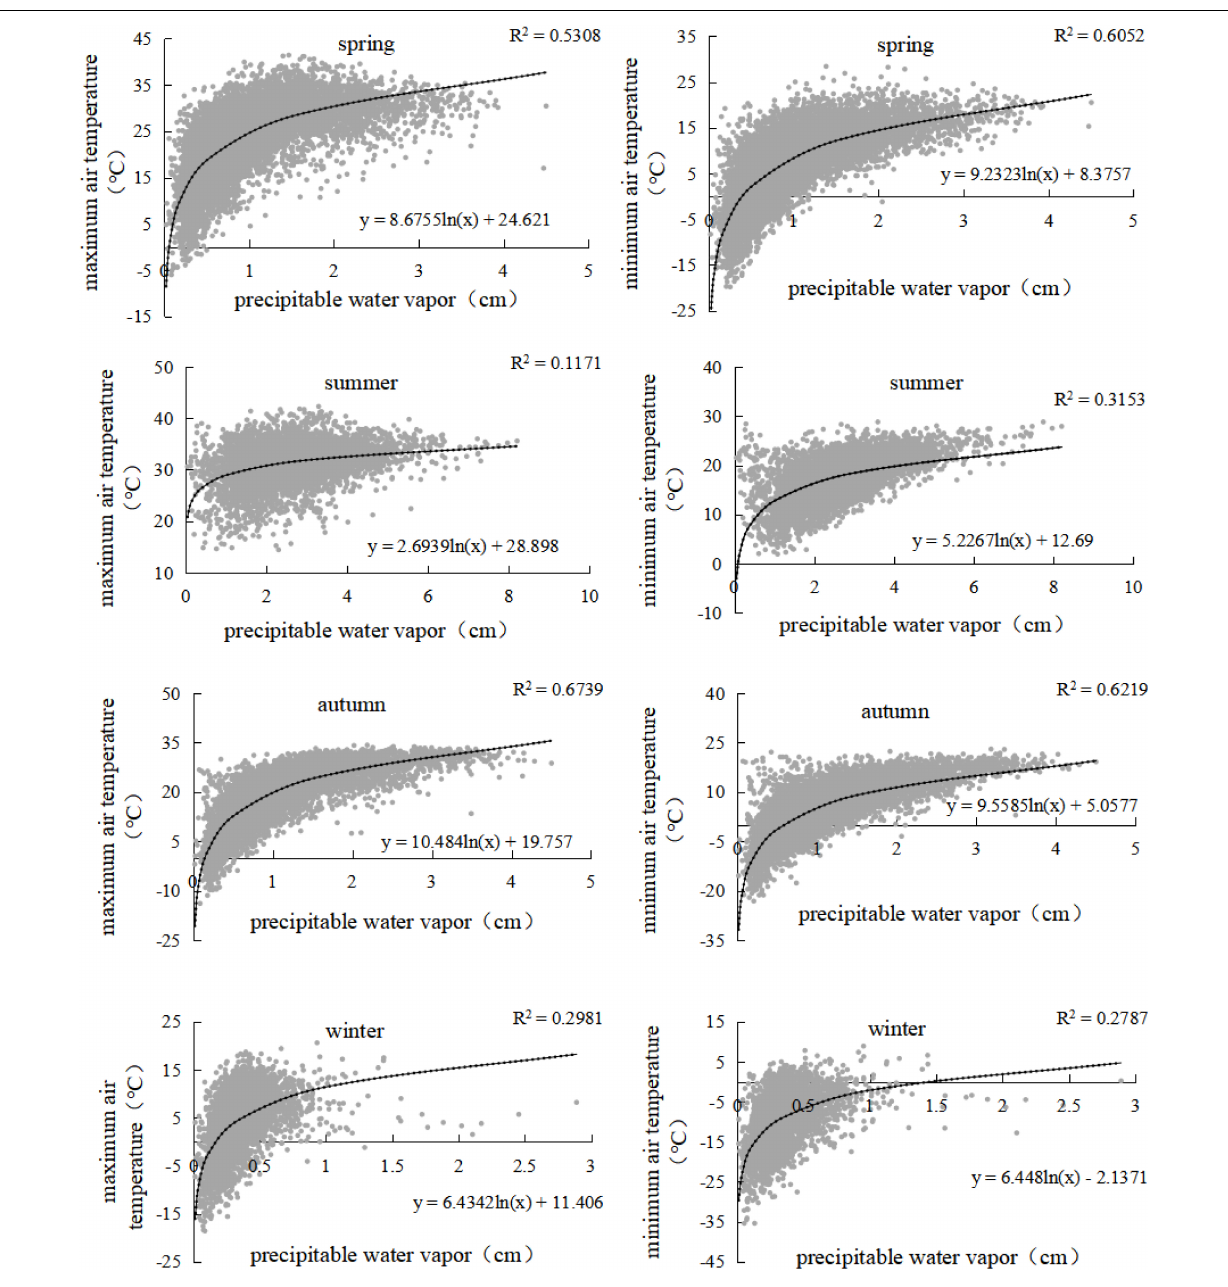
net daily radiations were highly consistent with the observed ones, with the estimation accuracy within the acceptable